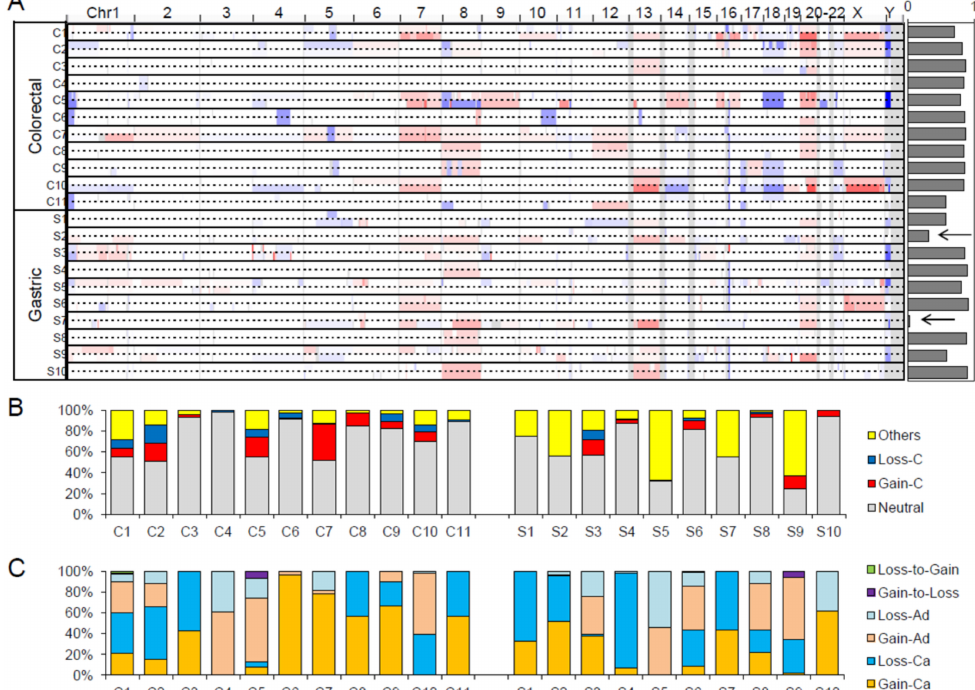
Figure 6. Somatic copy number alteration (SCNA) profiles of benign and malignant pairs. ( A ) Snapshot of Integrative Genomics Viewer (IGV) browser is shown as a genome-wide SCNA profile of 21 genomes examinations. The pairs of adenoma–carcinoma genomes are shown as pairs of individual lanes. The concordance level as the correlation between the segment level copy number ratios between the matched adenoma and carcinoma genomes are shown on the right. Arrows are for two cases with relatively discordant (correlation < 0.5) cases. ( B ) The correlation ( x -axis) and the case numbers ( y -axis) are shown to demonstrate that these four cases are outliers from the majority of the cases. ( C ) Six classes of SCNA changes during the adenoma–carcinoma